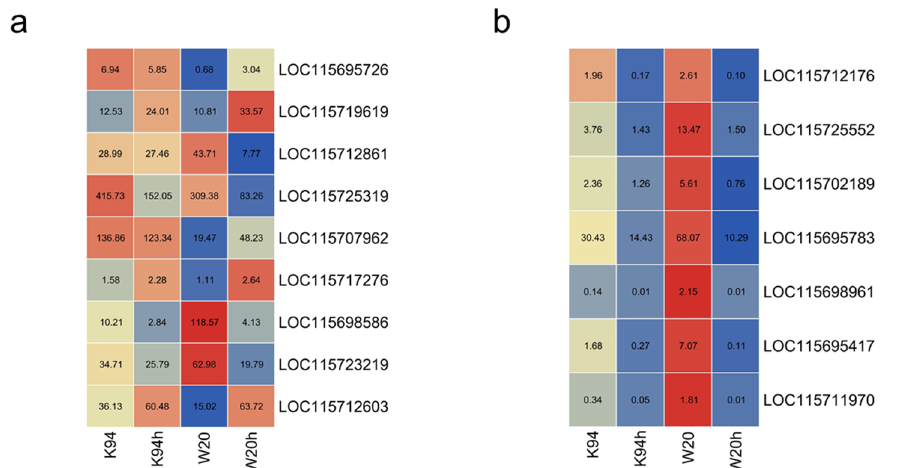
Figure 7. Identification and functional annotation of DEGs between treatment and control, gener ‐ ated using high ‐ throughput deep sequencing technology. ( a ) Volcano plot comparing the expres ‐ sion profiles of DEGs between the W20 and W20h experimental samples. ( b ) Clustering analysis of DEGs between treatments and controls. The scale bar indicates upregulated (red) and downregu ‐ lated (blue) DEGs. The darker the color, the higher the expression; the lighter the color, the lower the expression. ( c ) Top 3 GO classification of all DEGs of W20 cannabis in the seedling stage. ( d ) The top 10 enriched KEGG pathways of all DEGs of W20 cannabis in the seedling stage.